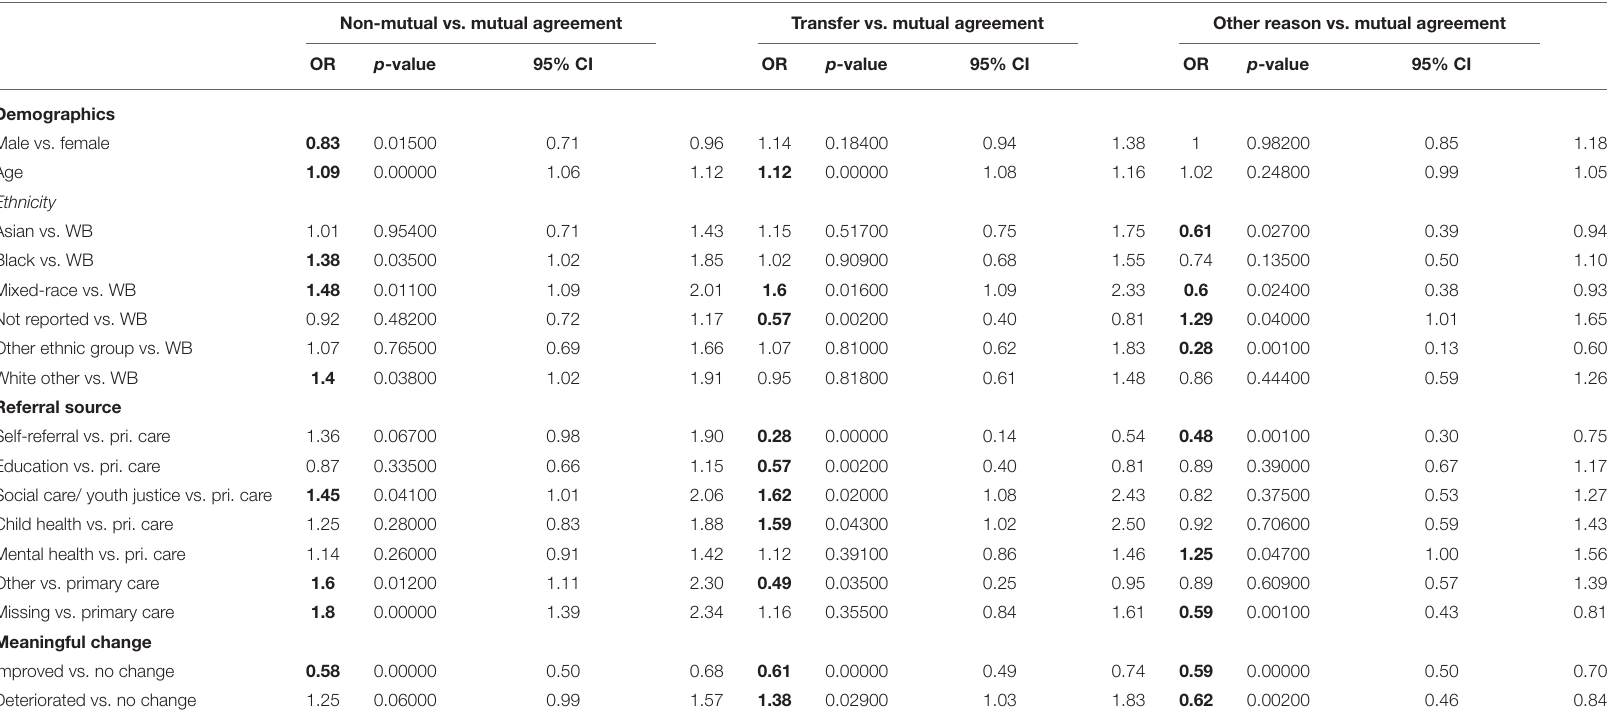
TABLE 2 | Multilevel multinomial regression with demographics, referral source, and meaningful improvement predicting case closure reason. Non-mutual vs. mutual